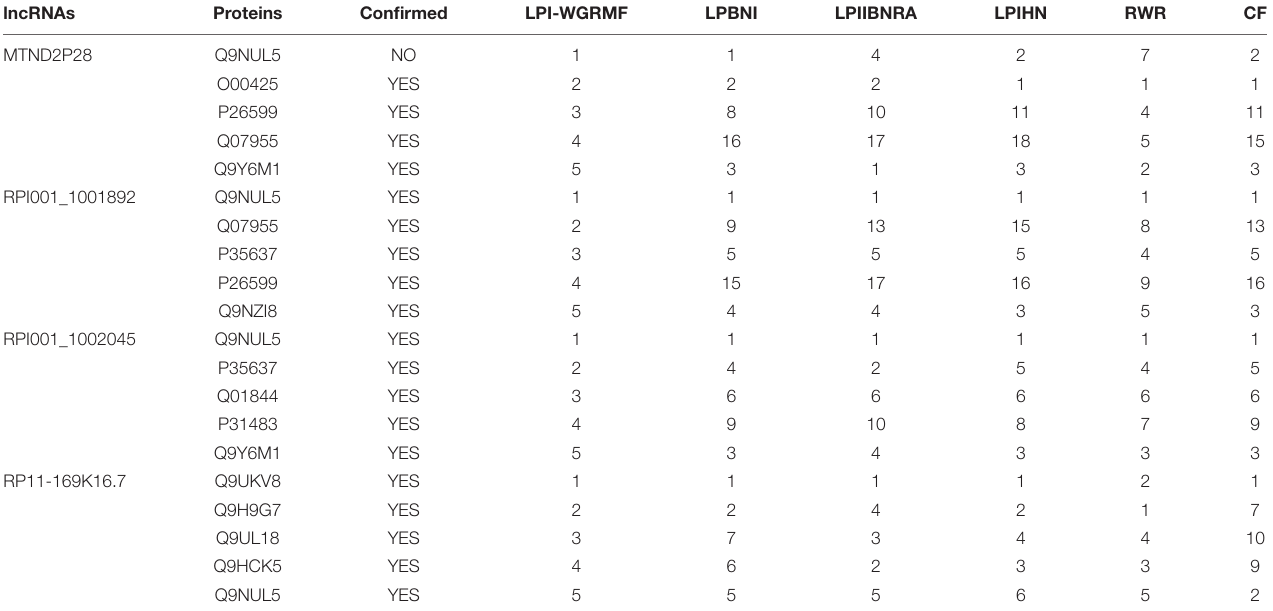
FIGURE 2 | The AUPR values of six LPI prediction methods. TABLE 2 | The top five proteins associated with the four lncRNAs.